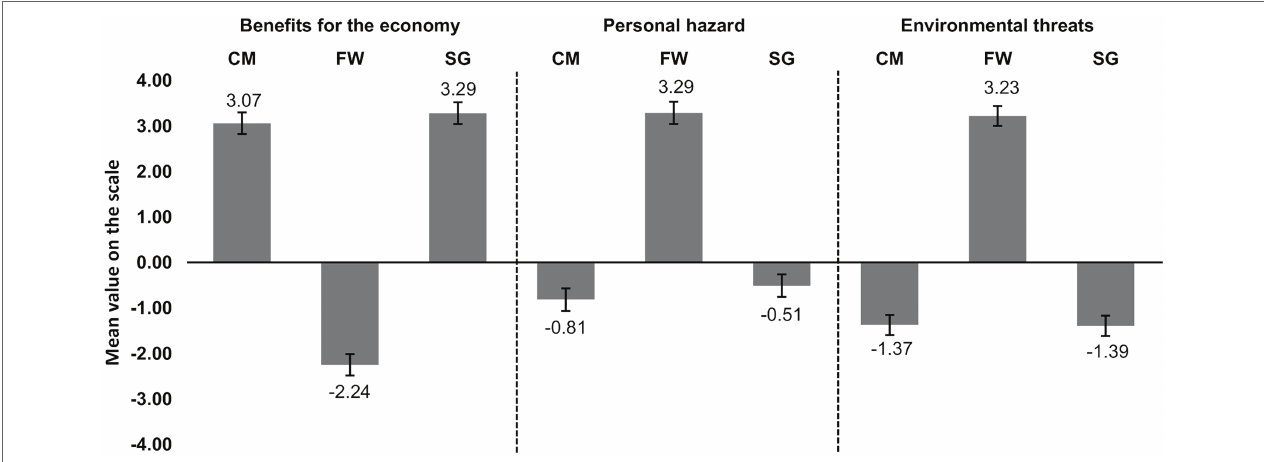
FIGURE 1 | Means with 95% CIs across the three dependent variables [the perception of benefits to the economy (BE), personal hazard (PH), and environmental threats (ET)] in groups of hard coal miners (CMs), fish processing factory workers (FWs), and security guards